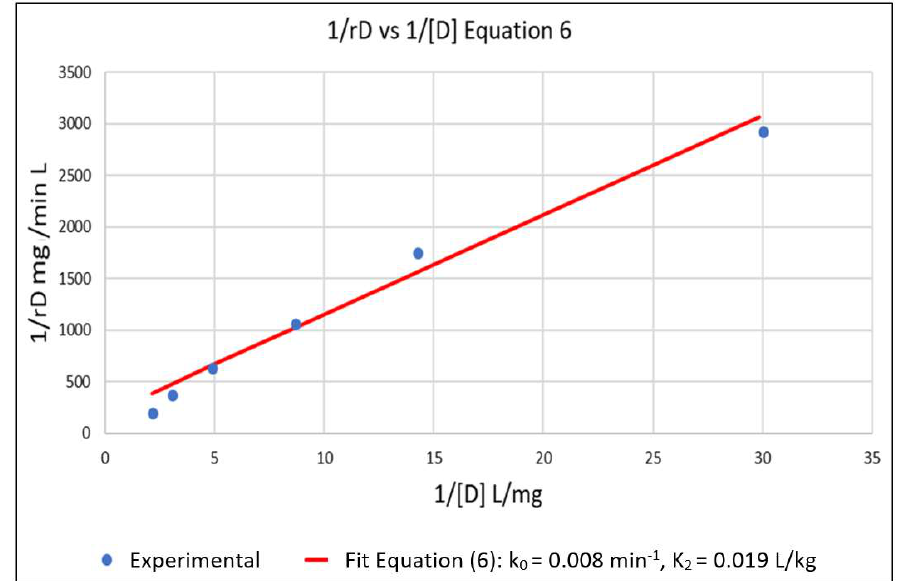
Figure 1. Setting [Cu 2+ ] = 0 in Equation (5) gives Equation (6) which is linear in 1/ r D versus 1/[D]. This allowed for the estimation of k 0 and K 2 from the slope and intercept of the plot. k 0 = 0.008 min −1 and K 2 = 0.019 L/mg.